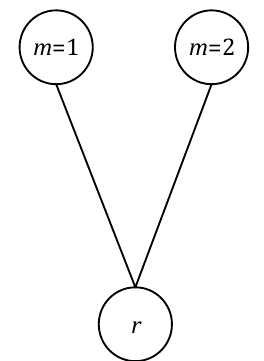
Fig. 1. Interaction between wholesalers and